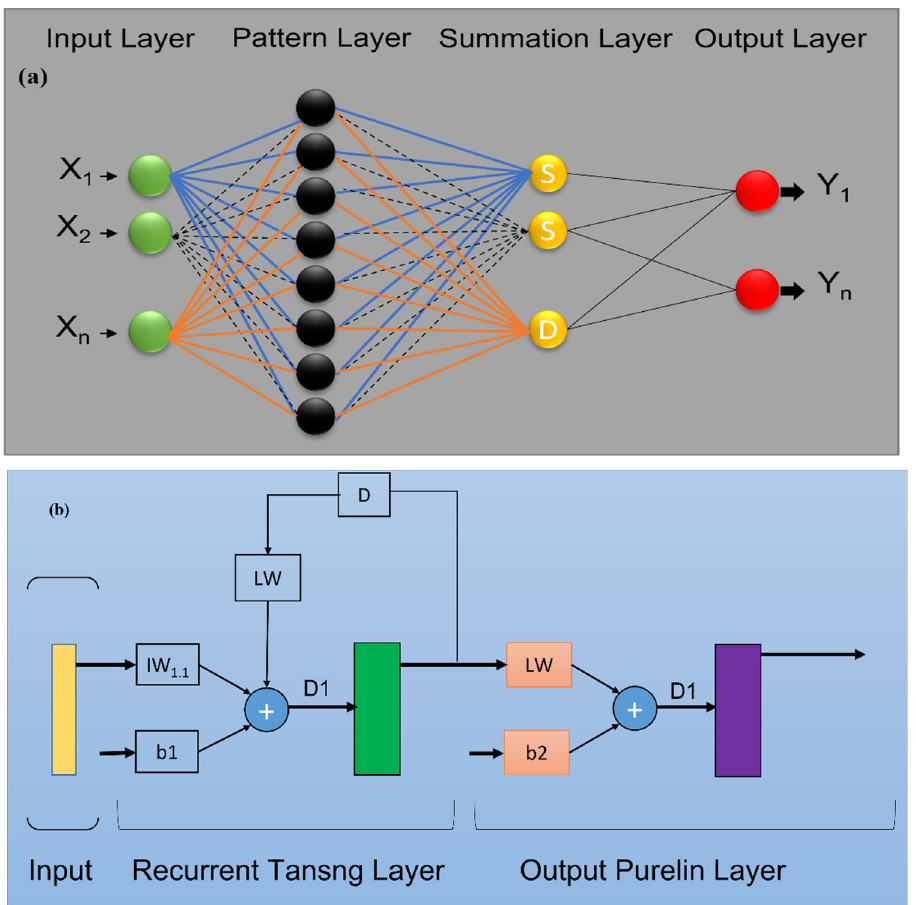
Figure 6. Proposed architecture for ( a ) generalized neural network (GRNN) and ( b ) Elman neural network (Elm NN).